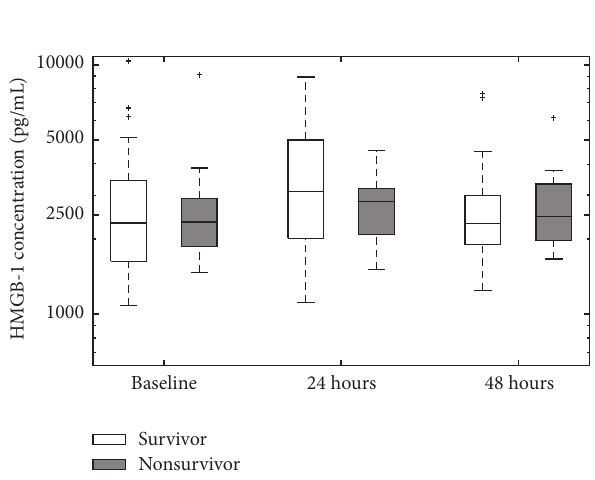
Figure 1: Plasma HMGB-1 levels at enrolment and 24 and 48